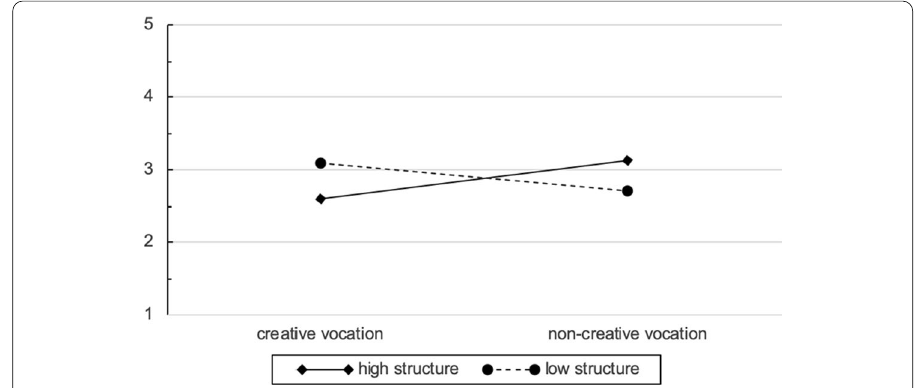
Fig. 5 Interaction effect of vocation_study_choice*group for situational